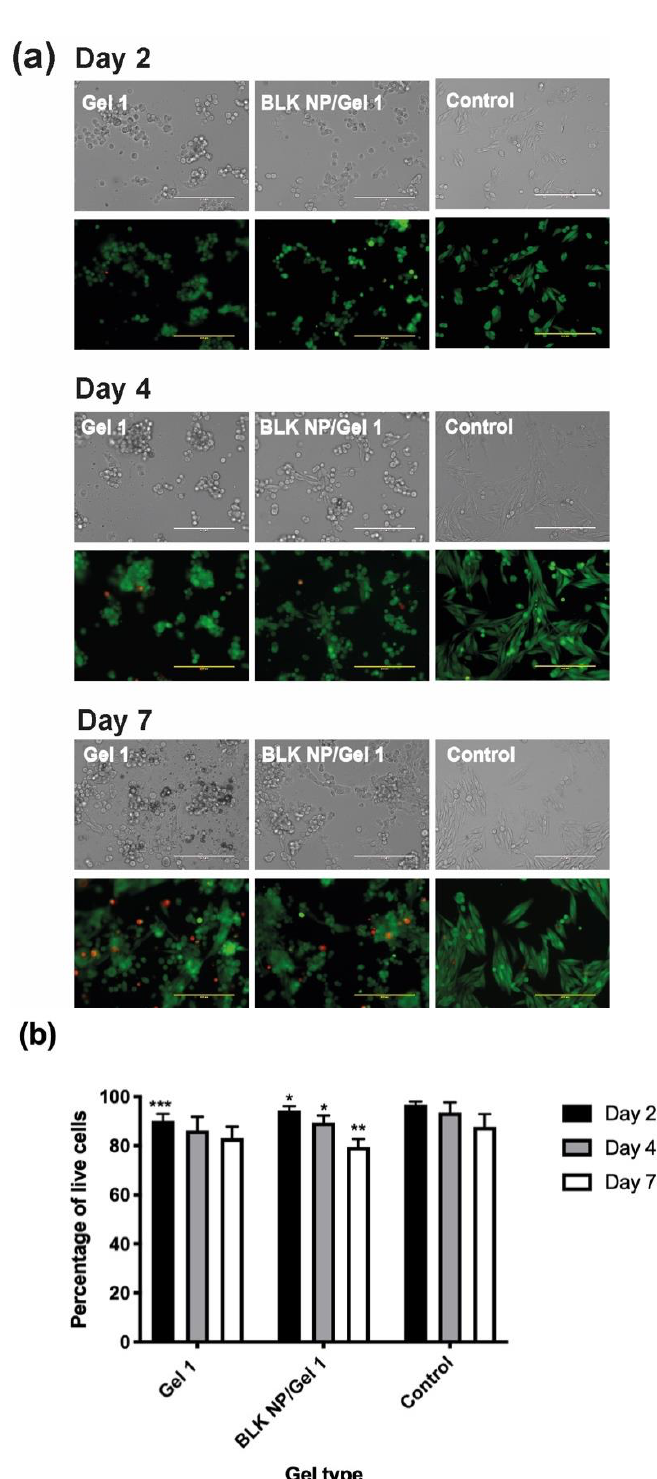
Figure 10. ( a ) Bright field and fluorescence images of MP-38 cells grown on CO–HA Gel 1 and blank NP (BLK NP)/Gel 1 composites at day 2, day 4, and day 7. MP-38 cells cultured in a 96-well culture plate were studied as a control. Scale bar: 200 µ m. The MP-38 Cells were labeled with the LIVE/DEAD assay. Green and red fluorescence indicate live and dead cells, respectively. ( b ) Quantification results of live cell (%) of testing group: Gel 1, BLK NP/Gel 1 composites and the control ( n = 3). Statistical analysis comparing experimental groups to the control group on the same day; * p < 0.05, ** p < 0.01, *** p <